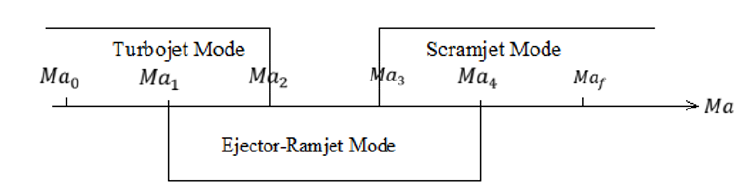
Figure 3. Working Mach range of each mode of